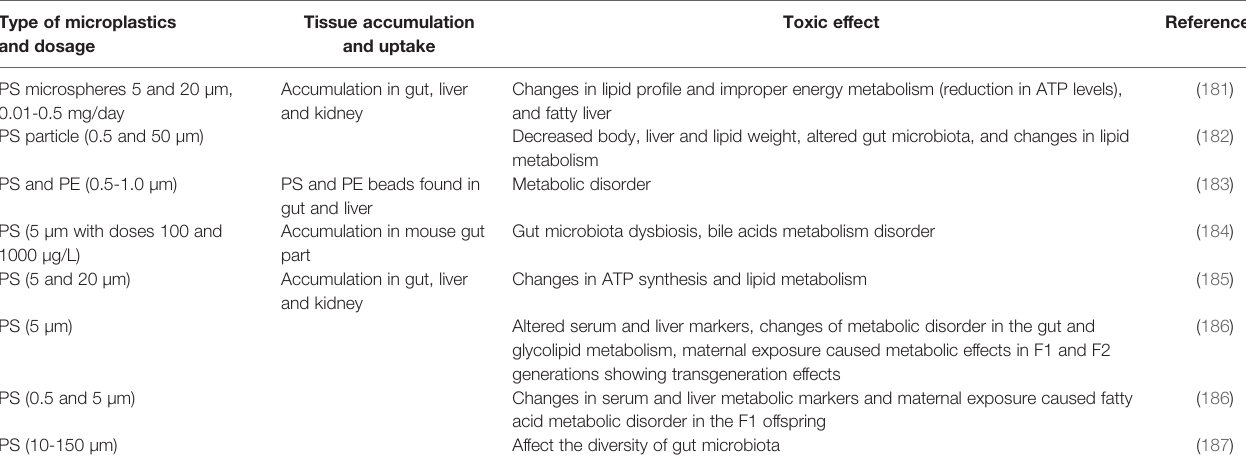
TABLE 2 | Toxic effects of microplastics as related to obesogenic effects in laboratory animals (mostly mice). Type of microplastics and